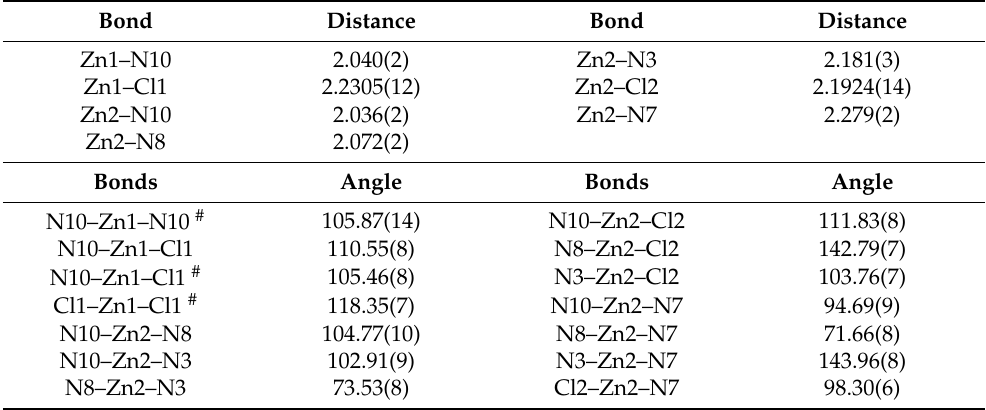
Symmetry code: # − x,y,1/2 −